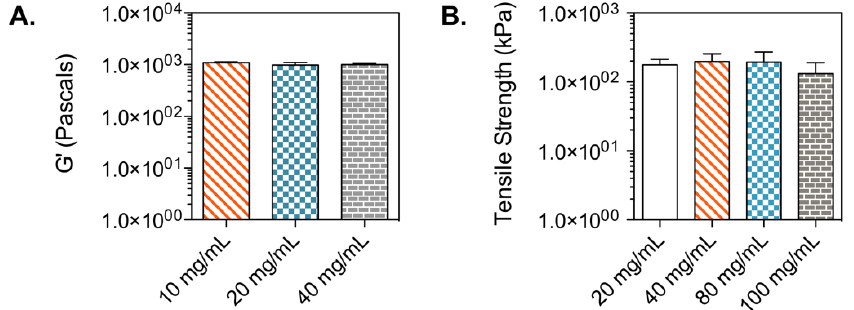
Figure 2. Tensile strength of lisinopril and spironolactone gels. ( A ) Tensile strength of lisinopril tablets with diverse drug concentrations. Forty mg/mL was the maximum solubility achieved for this active pharmaceutical ingredient (API) in this bioink formulation. No statistical difference was observed between samples with varying lisinopril concentrations. ( B ) Tensile strength of spironolactone tablets with diverse drug concentrations. One-hundred mg/mL was the maximum solubility achieved for this API. No statistical difference was observed between samples with varying concentrations.